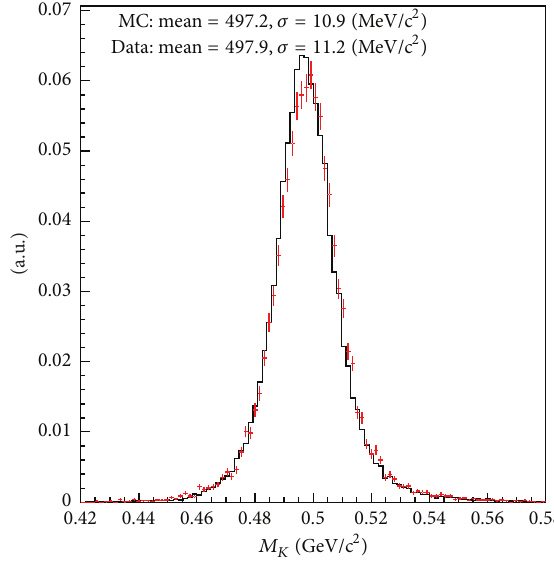
Figure 7: 𝜋 + 𝜋 − mass distribution showing the signal of 𝐾 0 (from [9]).